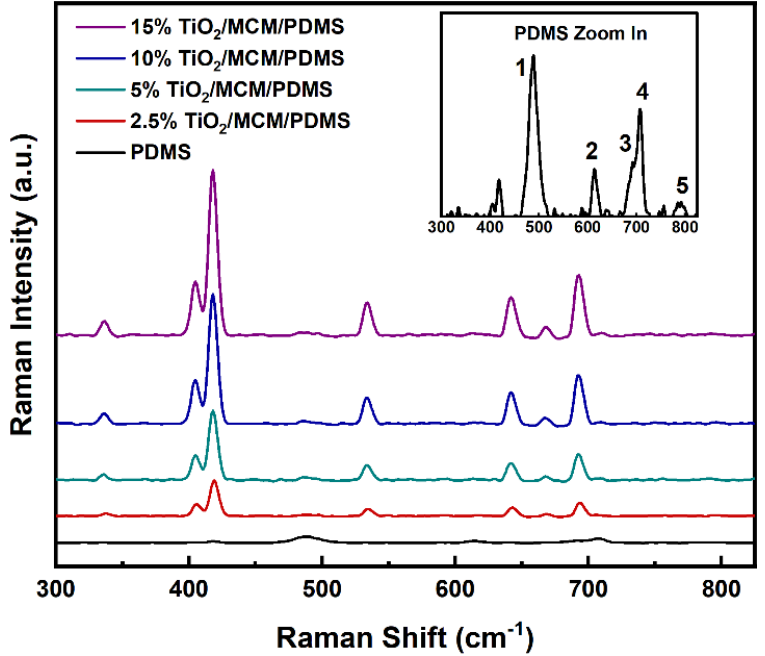
Figure 2. Raman spectra of pristine PDMS and TiO 2 /MCM/PDMS composites.